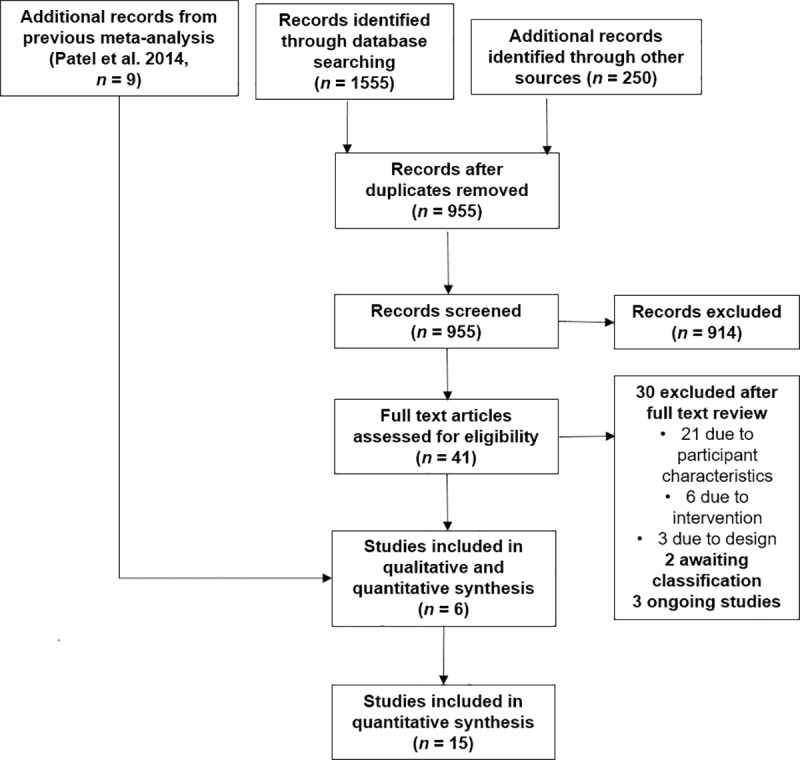
Study flow diagram.